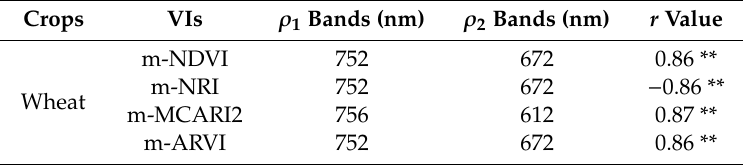
Figure 8. Pearson correlation coefficients ( r values) between the simulated LAI and m-VIs derived from the refined ρ 1 and ρ 2 . ( a ) m-NDVI, ( b ) m-NRI, ( c ) m-MCARI2, and ( d ) m-ARVI. Table 10. Specific optimal bands of ρ 1 and ρ 2 for the four m-VI calculations.